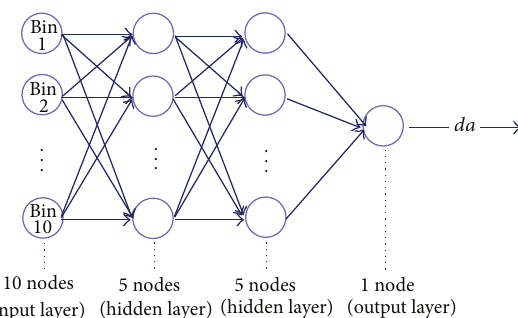
Figure 8: Artificial neural network created to determine the extent of crack growth for a small time